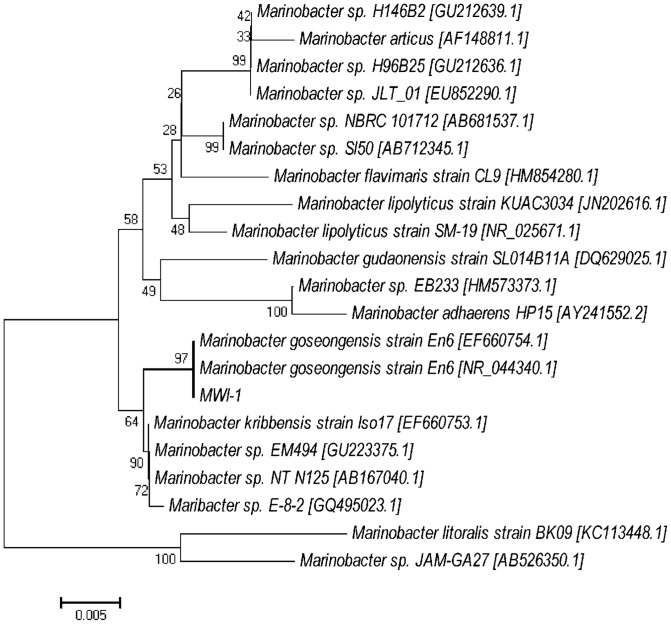
Phylogenetic tree using the neighbour-joining method, constructed and based on the bacterial 16S rRNA gene sequence detected in the present study along with similar sequences detected from the NCBI and RDP databases.